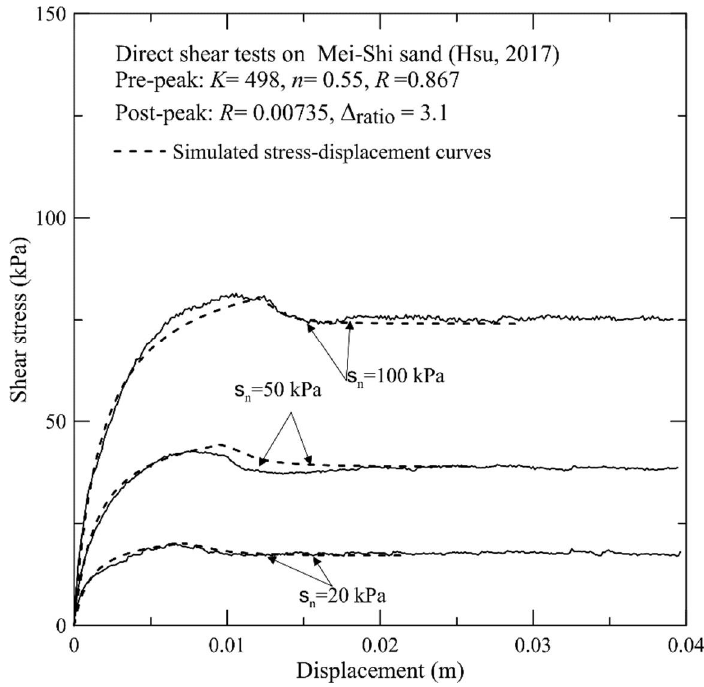
Figure 7. Comparison of calculated and experimental stress-displacement curves reported by Hsu (2017). Table 1. Input parameters used for simulating stress-displacement curves reported by Wu (2011).